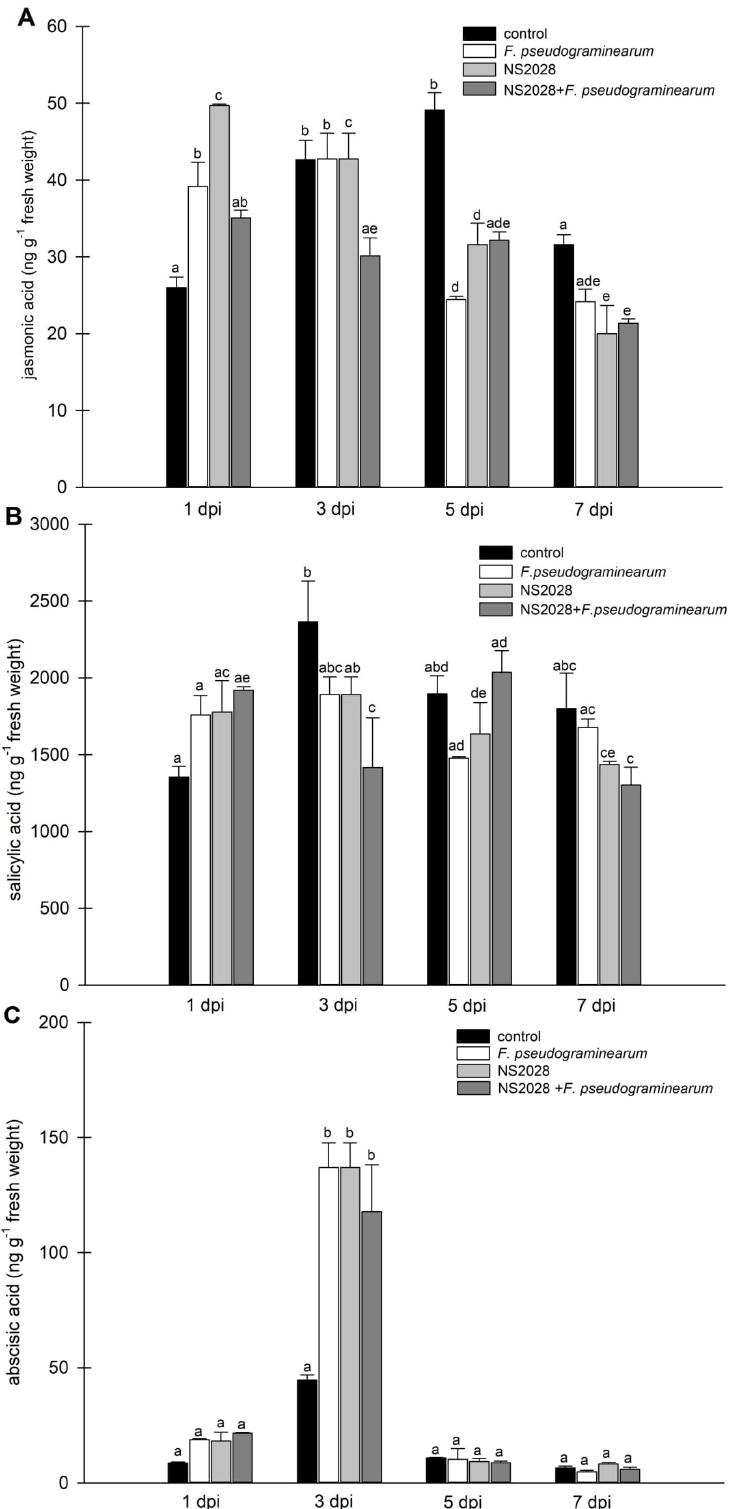
Figure 4. Determination of endogenous levels of phytohormones in B. distachyon infected with F. pseudograminearum . ( A ) Jasmonic acid; ( B ) salicylic acid; and ( C ) abscisic acid. Control plants were not infected or treated with the inhibitor. Data are shown as mean values ( n = 3), and error bars indicate the standard error of the mean. Different letters above the bars indicate significant differences at p < 0.05 (ANOVA followed by Tukey’s